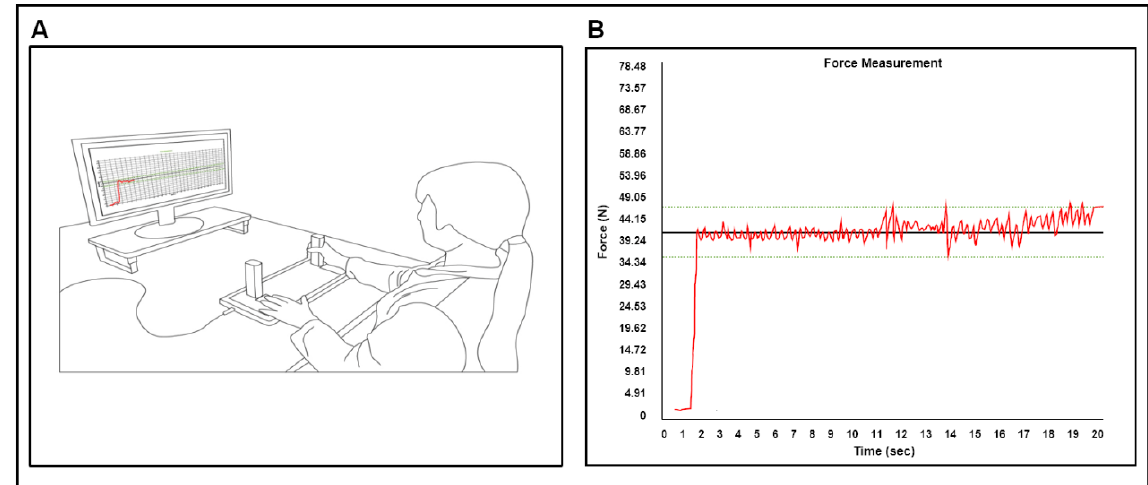
Figure 1: Experimental setup for unimanual force control task. ( A ) Participants used isometric hand- grip force measurement device to access unimanual MVC and force control capabilities at individual low targeted submaximal force level (i.e., 10 % of MVC). ( B ) Red line indicates individual force signals, black horizontal line denotes submaximal targeted force from individuals, and two green dotted lines are 10 % of threshold from targeted force